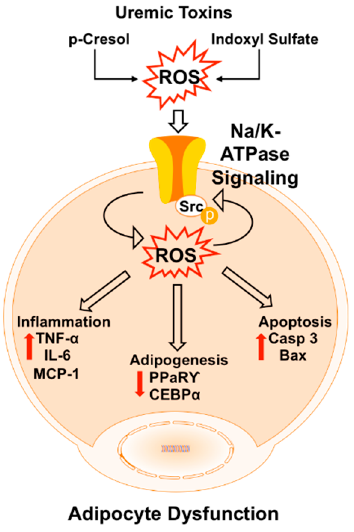
Figure 7. Schematic representation of Na/K-ATPase oxidant amplification loop-mediated phenotypic alterations in adipocytes, induced by the UTs in 3T3-L1 cells and MSCs-derived adipocytes.